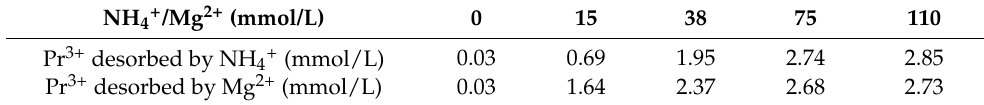
Figure 9. Influence of NH 4 + /Mg 2+ concentration on the recovery of Pr 3+ from Mt. Table 8. Concentration of NH 4+ , Mg 2+ and Pr 3+ in desorption solution. Table 8. Concentration of NH 4+ , Mg 2+ and Pr 3+ in desorption